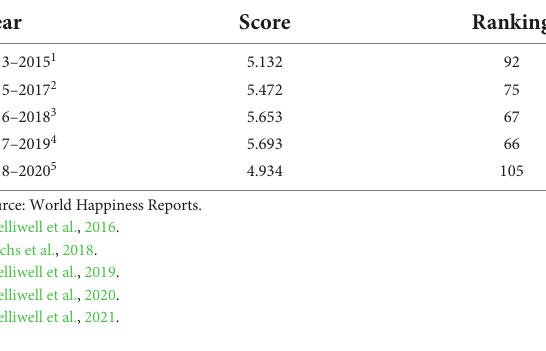
TABLE 1 Ranking of happiness in